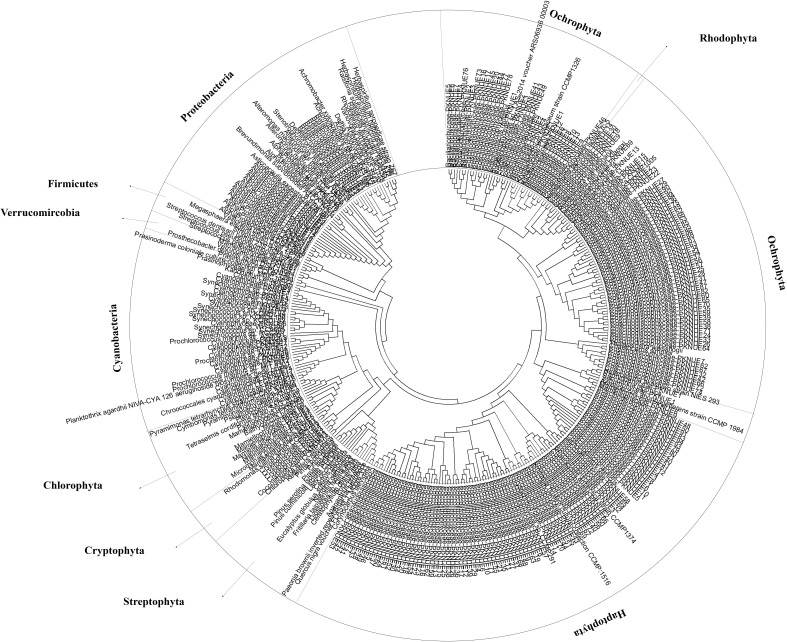
Coverage of obtained OTUs in algal phyla.Phylogenetic tree was constructed by the Neigbhor-joining (NJ) algorithm using Molecular Evolutionary Genetics Analysis (MEGA ver 6.0). The evolutionary distances were computed using the Kimura 2-parameter method.